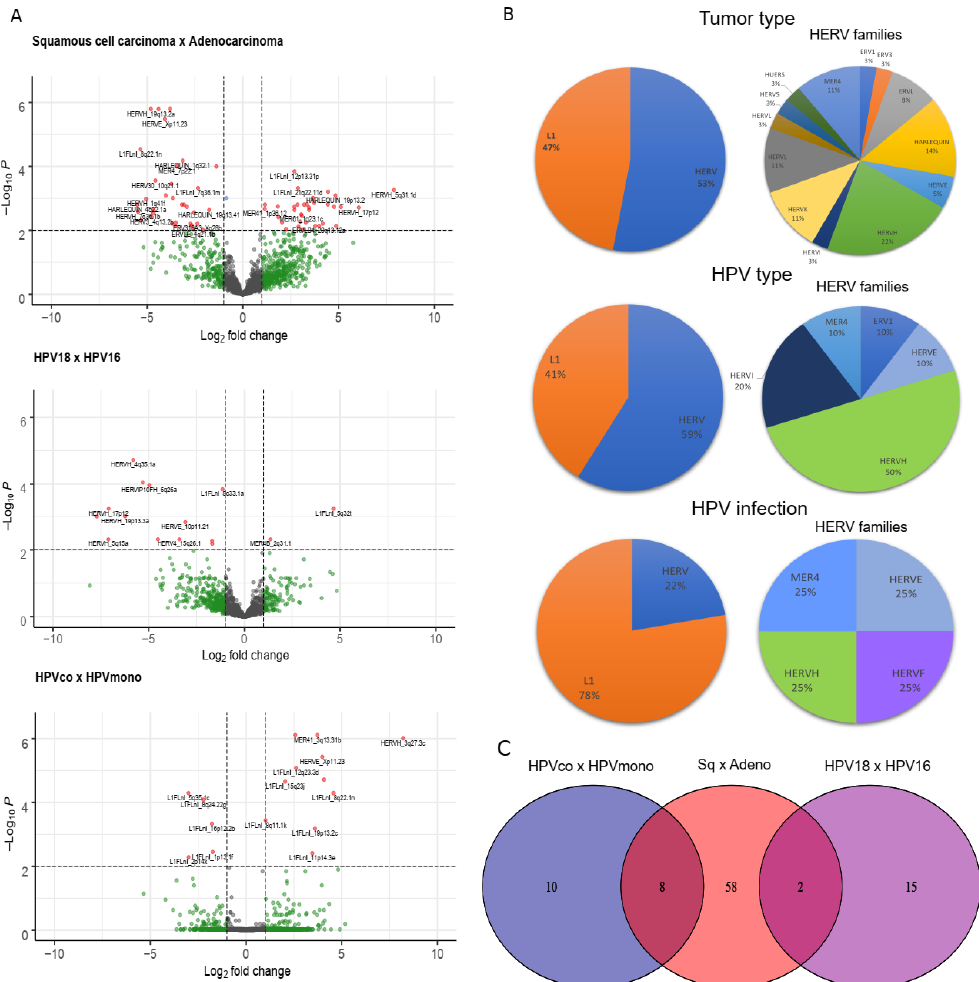
Figure 2. Retrotransposon loci differentially expressed in cervical cancer. ( A ) Volcano plot shows differentially L1 and HERV loci expressed with respect to cervical tumor histological type (squamous cell carcinoma x adenocarcinoma), infecting HPV type (HPV18 vs. HPV16) and HPV infection (HPV coinfection (HPVco) vs. HPV monoinfection (HPVmono)). ( B ) Proportion of differentially expressed L1 and HERV found in samples (left panels) and of HERV families found (right panels) with respect to each comparison depicted in A. ( C ) Venn plot shows exclusive and common HERV and L1 loci found in each analysis (squamous cell carcinoma (Sq) vs. adenocarcinoma (Adeno), HPV18 vs. HPV16 and HPVco vs.